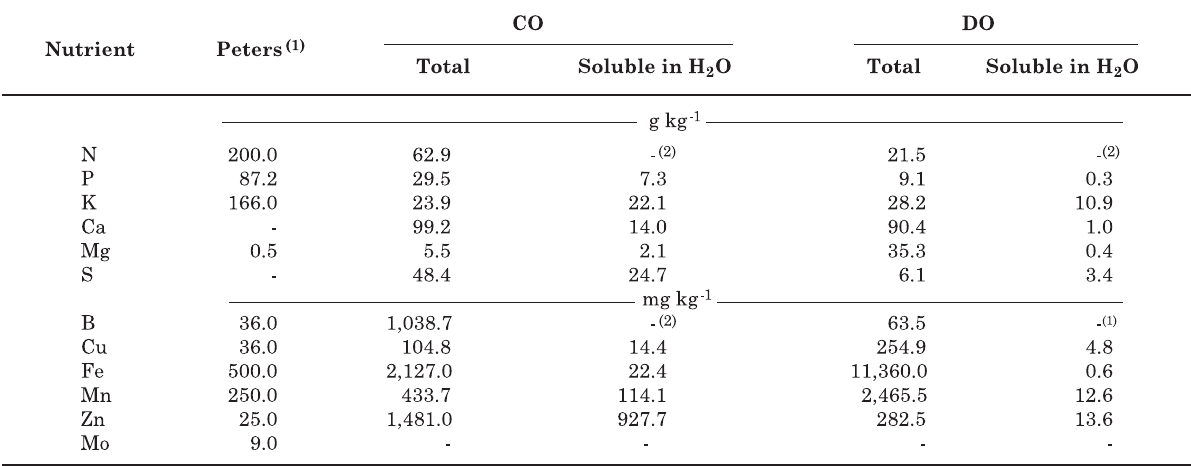
Table 2. Concentrations of macro- and micronutrients in Peters ® 20-20-20 combined with commercial organic (CO) and domestic organic fertilizers